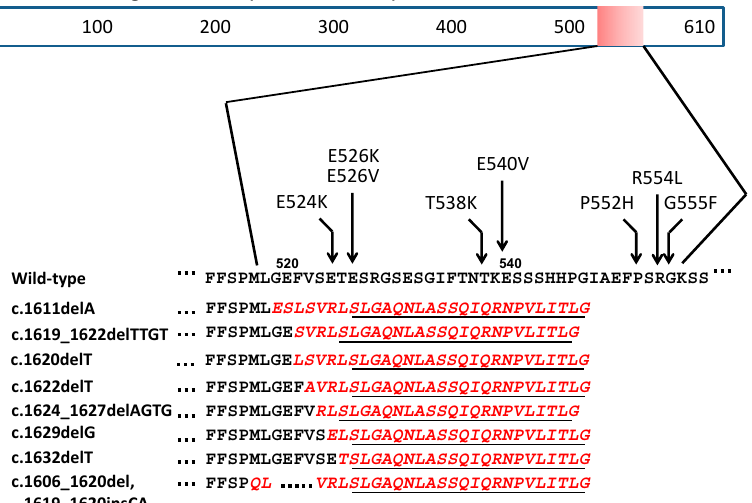
E524KE526VE526K P552HE540V R554L G555F 520 540 FFSPMLGEFVSETESRGSESGIFTNTKESSSHHPGIAEFPSRGKSS FFSPML ESLSVRLSLGAQNLASSQIQRNPVLITLG FFSPMLGE SVRLSLGAQNLASSQIQRNPVLITLG FFSPMLGEF AVRLSLGAQNLASSQIQRNPVLITLG FFSPMLGEFV RLSLGAQNLASSQIQRNPVLITLG FFSPMLGEFVS ELSLGAQNLASSQIQRNPVLITLG FFSPMLGEFVSE TSLGAQNLASSQIQRNPVLITLG Figure 3. The location of 16 amyloidogenic FGA variants. All amyloidogenic variants crowd in a quite limited portion from residue 517 to 555 of the mature A α -chain. In eight frameshift variants, the C-terminal sequences resulted from frameshift variants (red italic letters) bear a close resemblance to each other, and the C-terminal peptides consisting of 24 amino acids (underline) are identical.